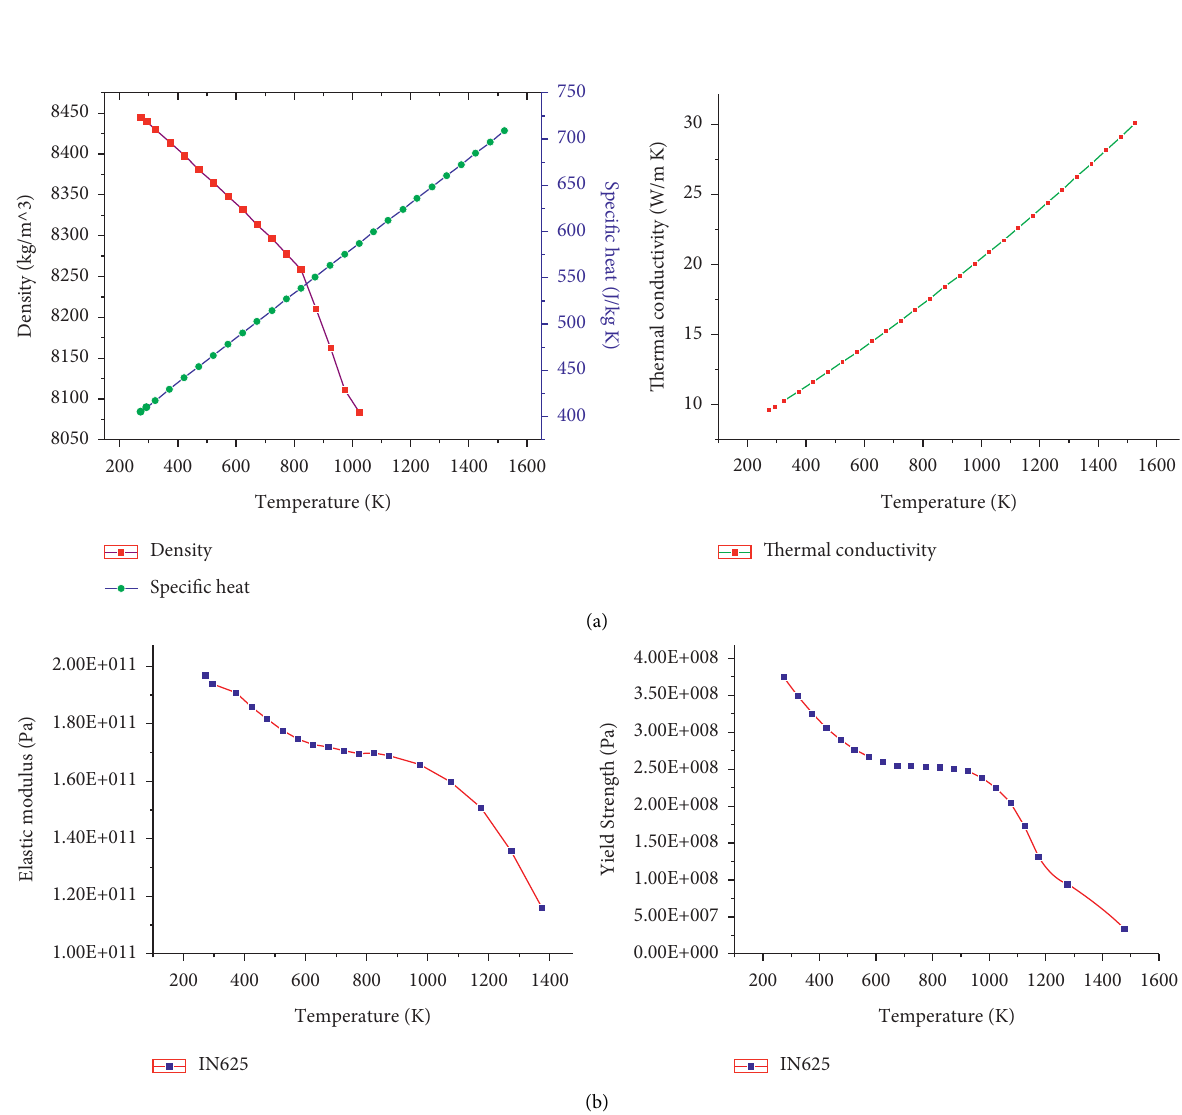
Figure 4: Temperature-dependent material properties.